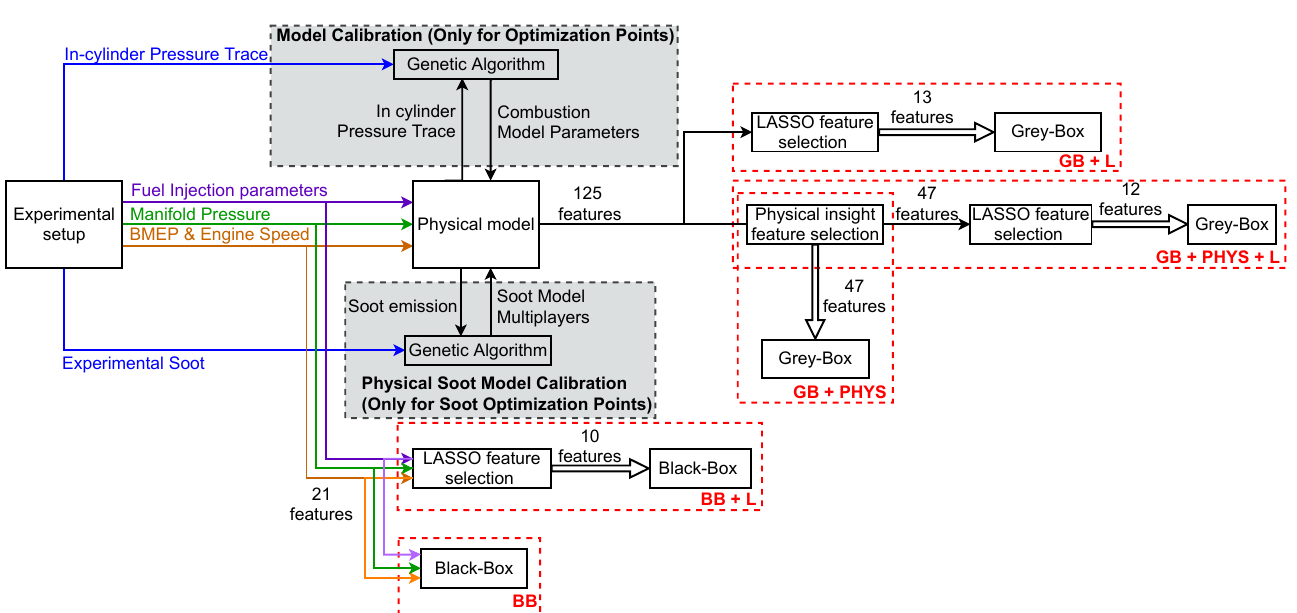
Figure 4. Physical model calibration and feature selection process.